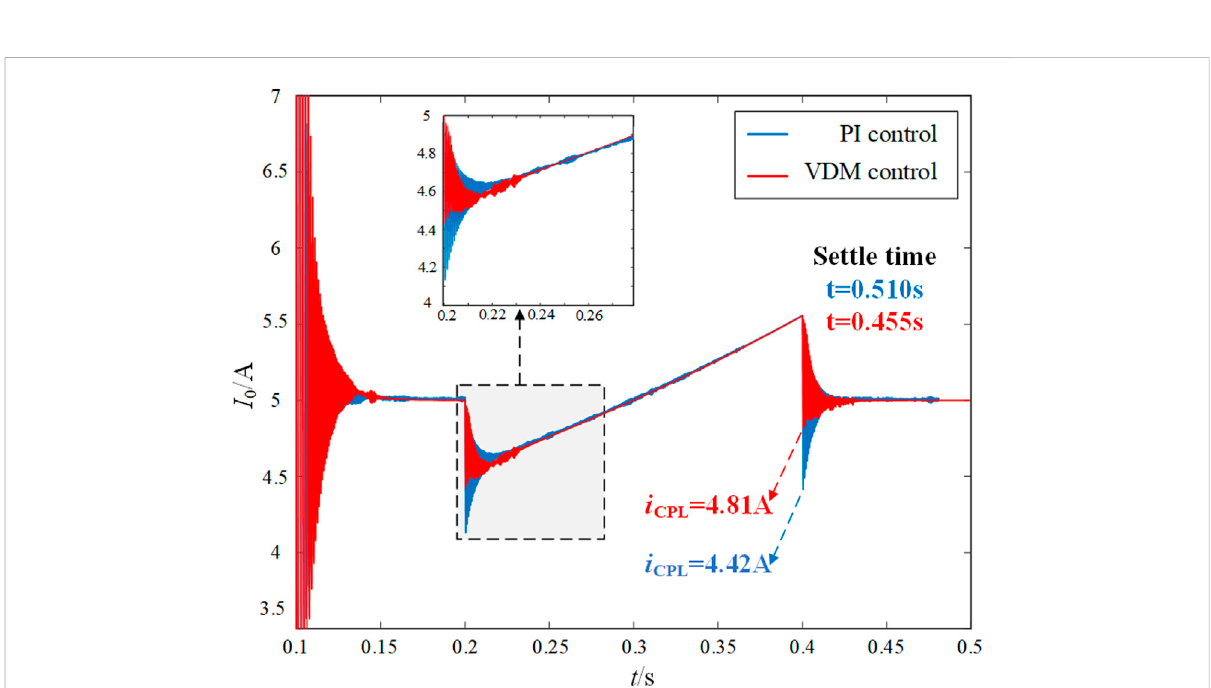
FIGURE 12 Comparison diagram of CPL current under CPL load linear change